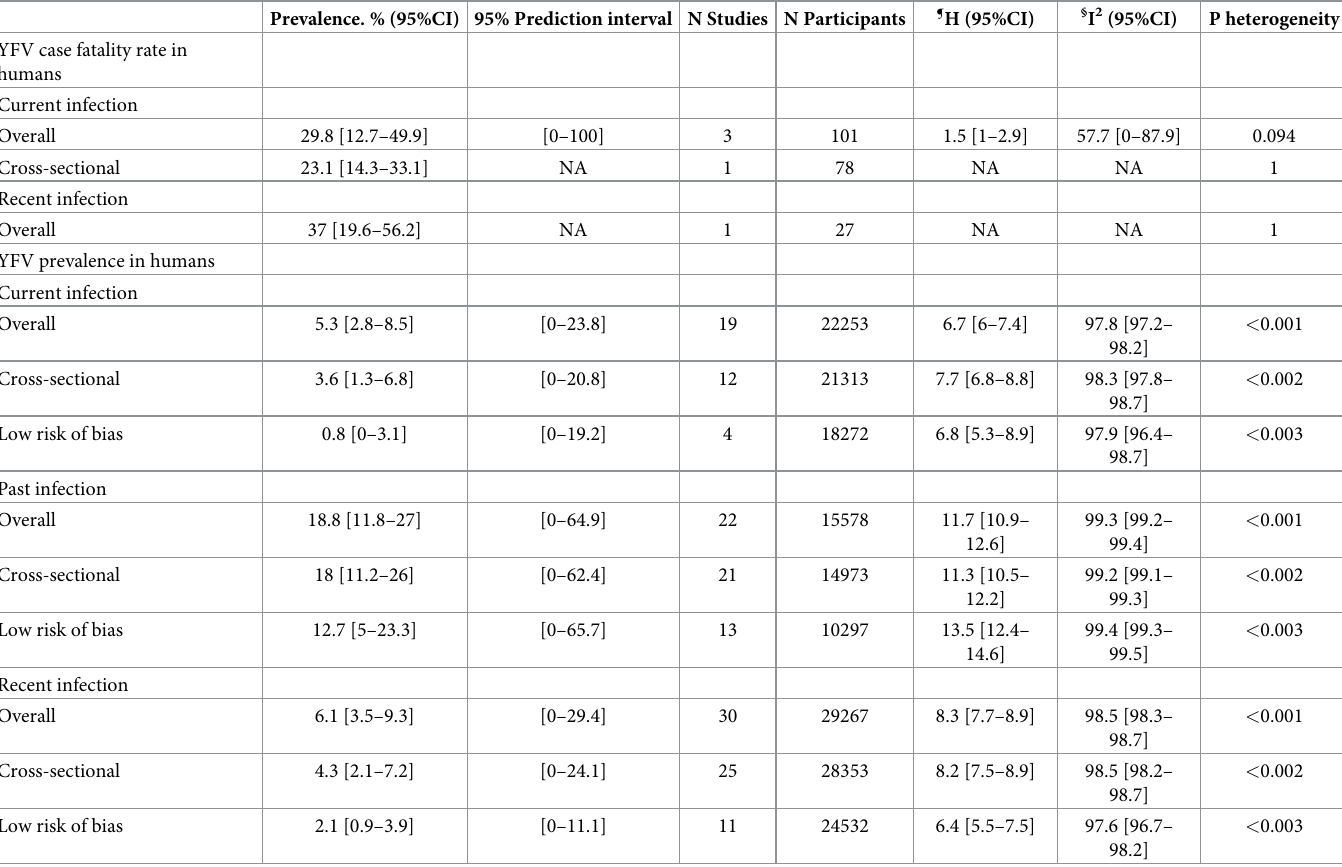
Table 1. Summary of meta-analysis results for case fatality rate and prevalence of yellow fever virus in humans in sub-Saharan